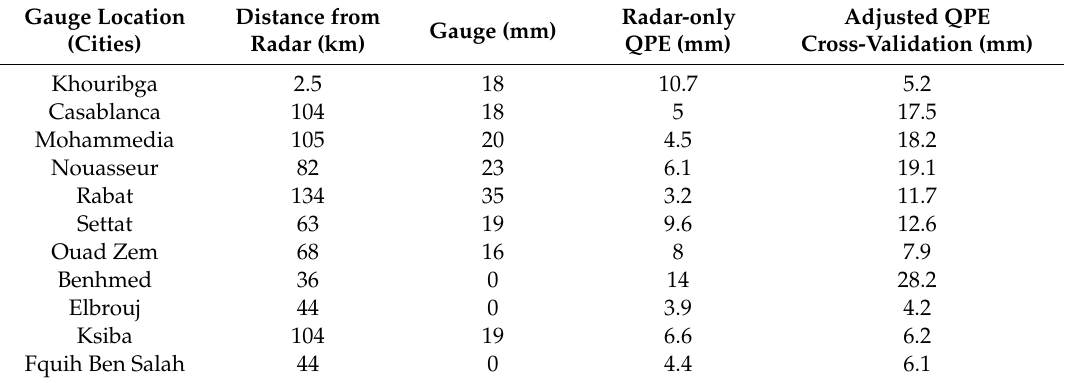
Table 2. Rain gauge measurements, 24 h radar-only QPE and adjusted QPE cross-validation at di ff erent gauge locations for December 16,